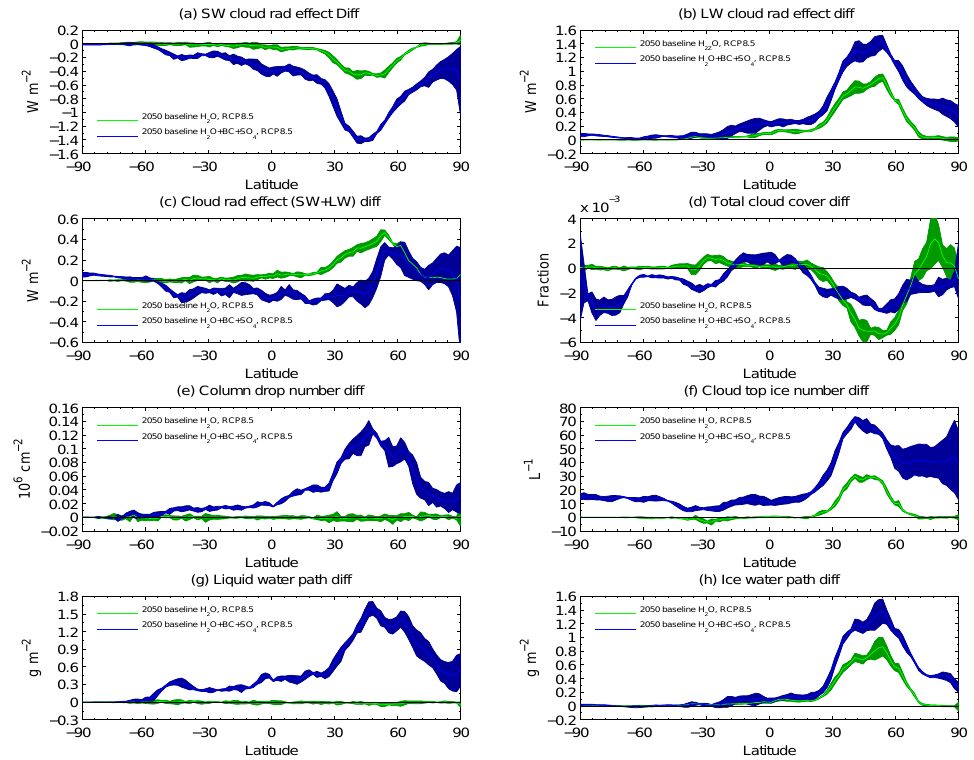
Figure 4. Zonally averaged aviation impact with the green line representing water vapor emissions only of baseline in 2050 and the blue line representing water vapor and aviation aerosols of baseline in 2050, both coupled with the background meteorology in 2050 by RCP8.5: (a) shortwave cloud forcing, (b) longwave cloud forcing, (c) net cloud forcing, (d) total cloud difference, (e) column drop number difference, (f) cloud top ice number difference, (g) liquid water path difference and (h) ice water difference. The spread of each curve represent the 2 standard deviations from the four-member ensemble of each